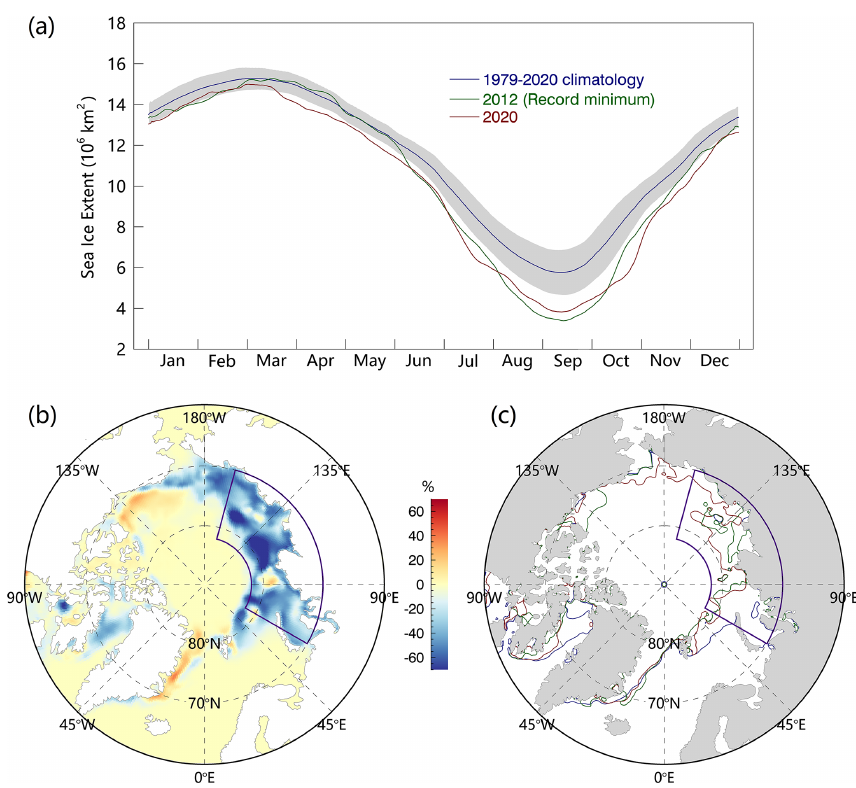
Figure 1. (a) Daily SIE of the Arctic in 2020 and 2012, and the climatology during 1979–2020. The shadows denote mean plus or minus 1 standard deviation. (b) Spatial patterns of SIC anomalies (shading) and (c) the SIEs in typical years (bold lines). The red line represents the SIE in July 2020. Green and navy-blue lines denote the SIE in July 2012 and the 42-year average of the period 1979–2020, respectively. The anomalies are computed as the difference between the fields in July and the corresponding climatology over the past four decades (1979– 2020). Purple polygons encapsulate areas where substantial sea ice cover loss (60–165 ◦ E, 70–82 ◦ N) was observed in July 2020, which represents the study area of this